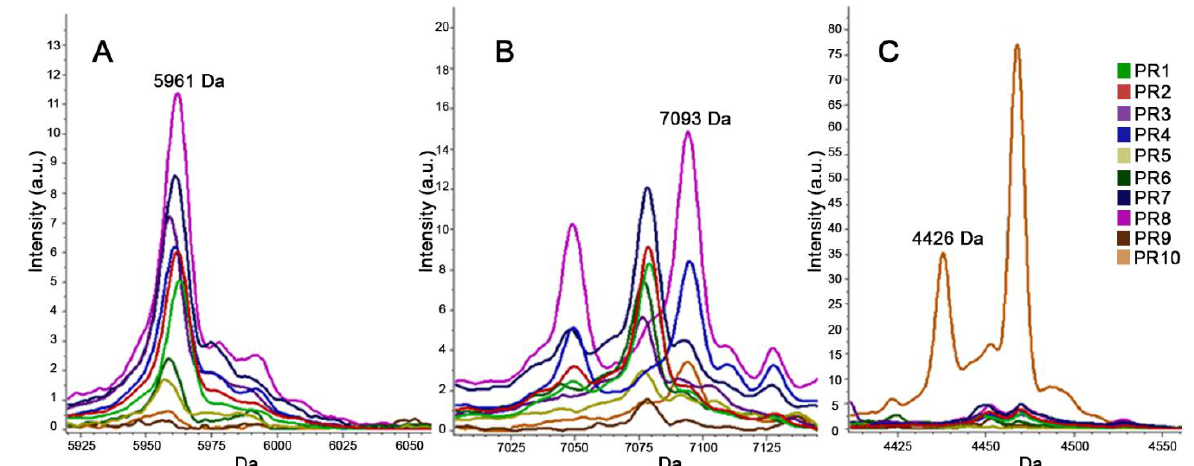
Figure 3. Examples of discriminating peaks able to differentiate the 10 different ribotypes found. ( A ): peak of 5961 Dalton present in all ribotypes except in PR9 and PR10. ( B ): peak of 7093 Dalton present in ribotypes PR4, PR7, PR8, and PR10. ( C ): peak of 4426 Dalton present only in ribotype PR10. The spectra of the ribotypes PR1, PR2, PR3, PR4, PR5, PR6, PR7, PR8, PR9, and PR10 are shown in green, red, purple, blue, yellow, dark green, dark blue, pink, brown, and orange, respec- tively.